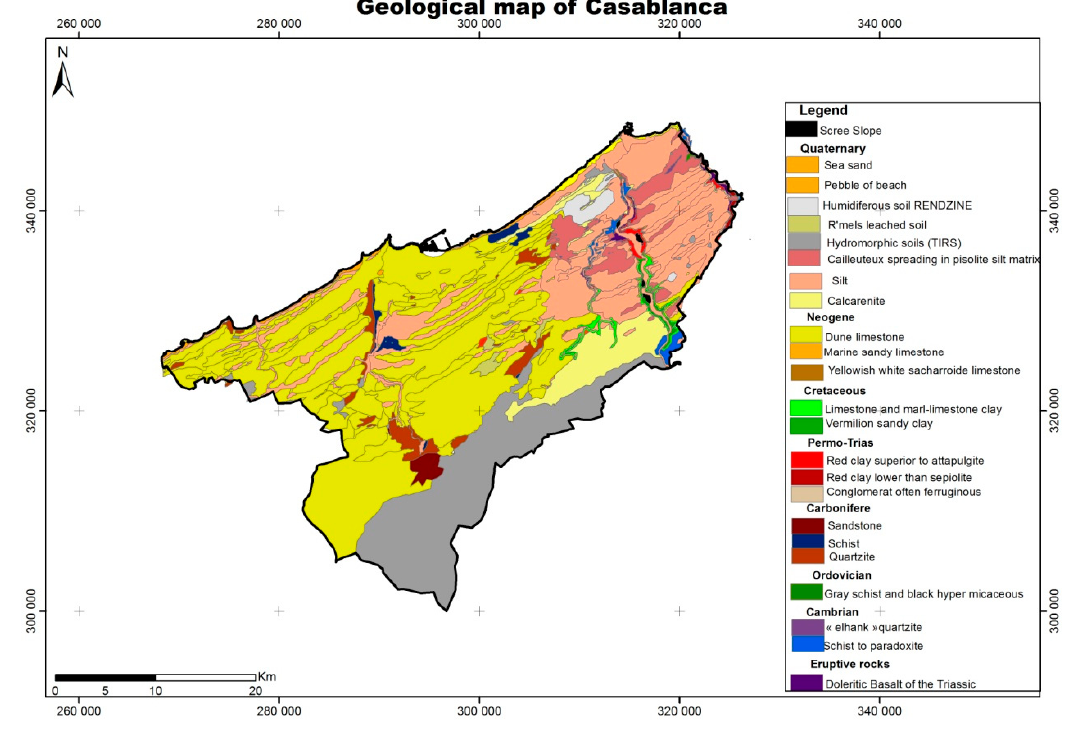
Figure 5. A geological map of Casablanca.